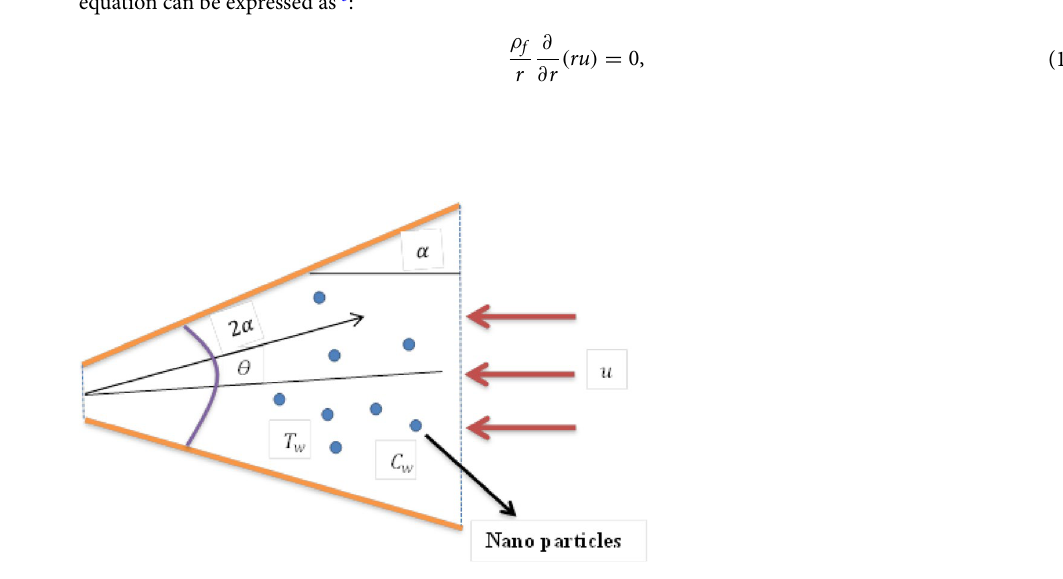
Figure 1. Geometrical flow